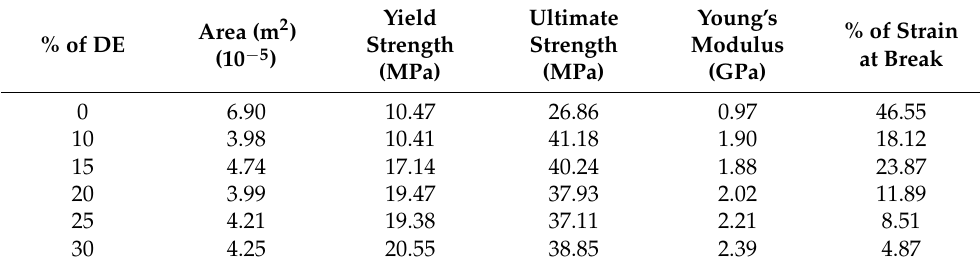
Table 4. Experimental mechanical properties of pure nylon-11.